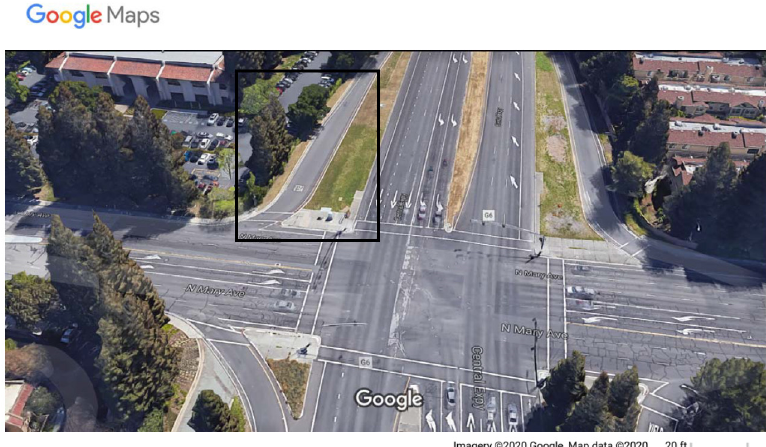
Figure 5. Traffic scenario from a bird’s-eye view. The crossing scenario at the exit lane is framed in black. Copyright: Imagery ©2020 Google, Map data ©2020. black. Copyright: Imagery © 2020 Google, Map data ©